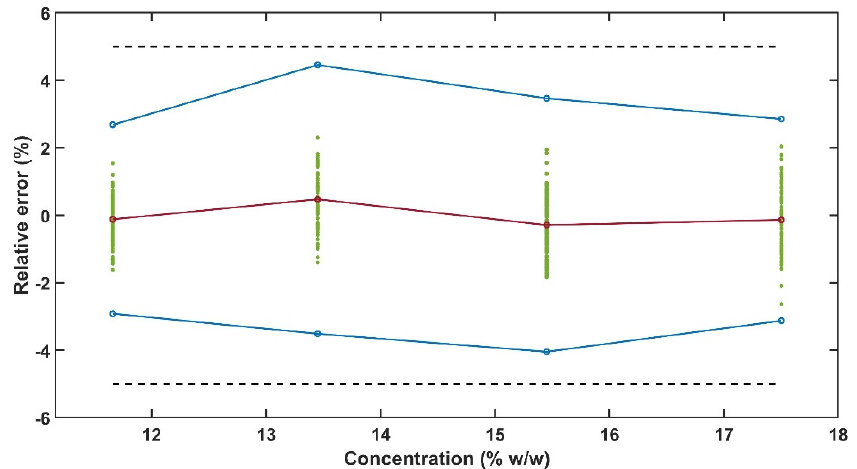
Figure 13. Accuracy profile with the dashed black lines indicating ± 5% limits, the blue lines with circles are the β -expectation tolerance limits, green points are the relative bias for every measurement and the red line with circles is the method mean relative bias.